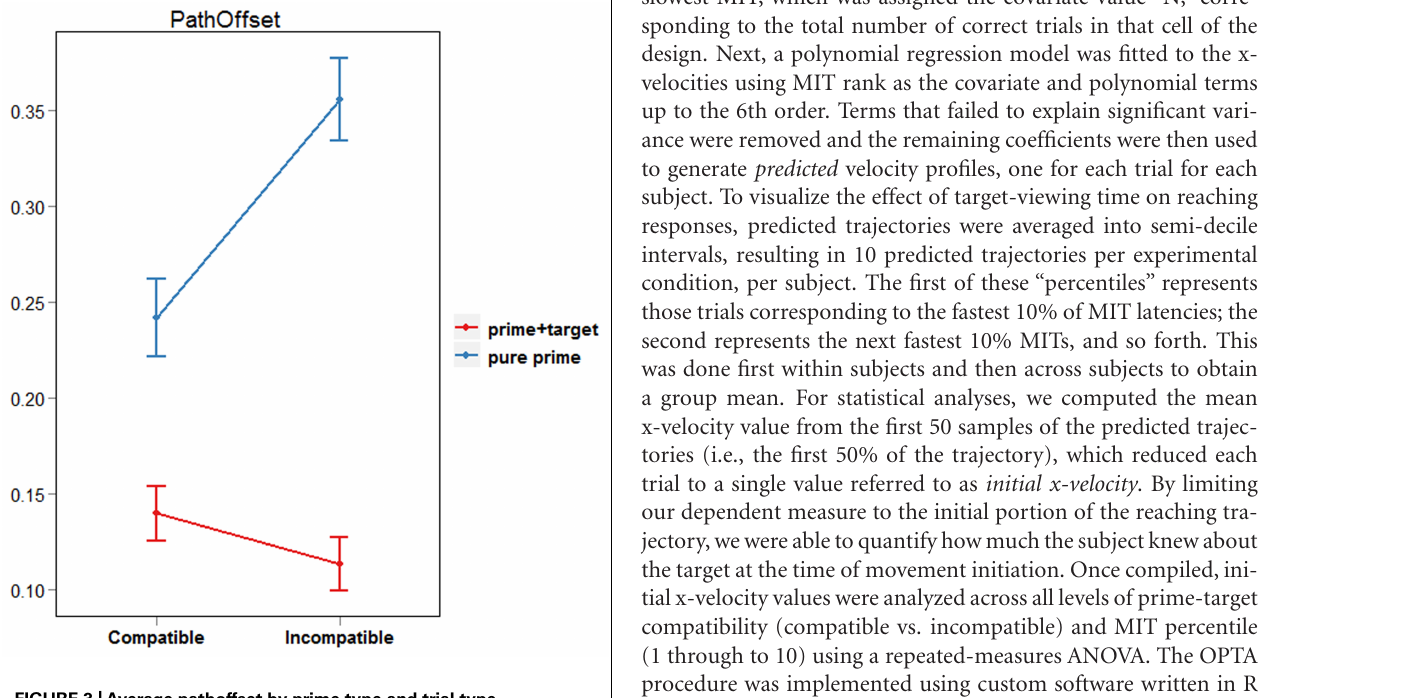
FIGURE 3 |Average pathoffset by prime type and trial